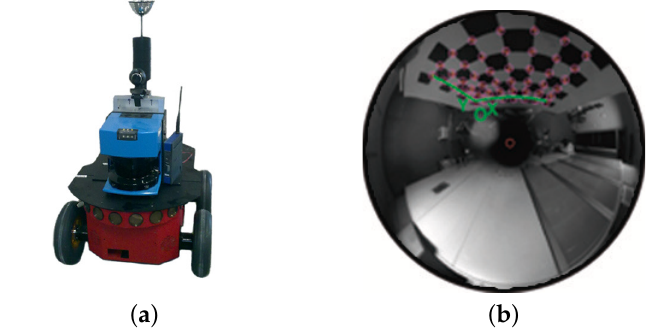
Figure 1. Real equipment used in this work: ( a ) Pioneer P3-AT mounted with an omnidirectional camera, internal odometer and laser range finder; ( b ) calibration procedure for the omnidirectional system.